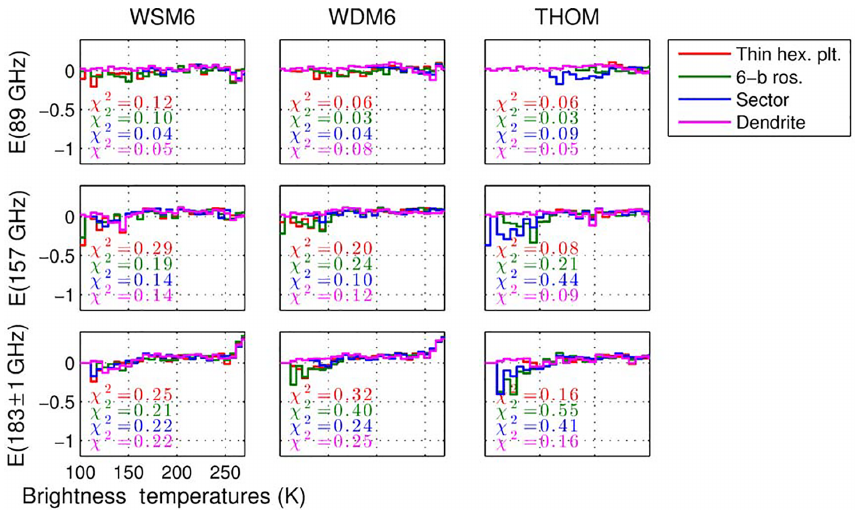
Figure 19. The simulated (solid coloured lines) residuals of the χ 2 test for the simulated MHS 89, 157 and 183 ± 1GHz channels for the MCS events on 13 January 2011 at 22:00UTC. Note that the χ 2 value is included for selected DDA habit simulated distributions calculated from all temperature bins below 270 and 250K for the 183 ± 1GHz